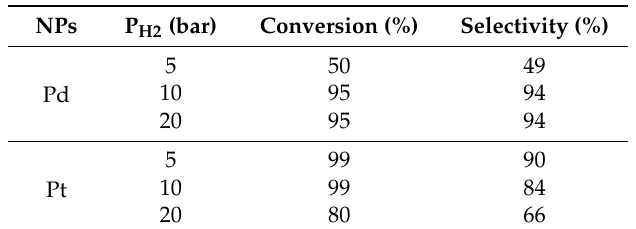
Table 1. Effect of H 2 pressure on conversion and selectivity of the Pd and Pt-catalyzed reduction of 3-methyl-2-cyclohexenone to 3-methylcyclohexanone. Reaction conditions: